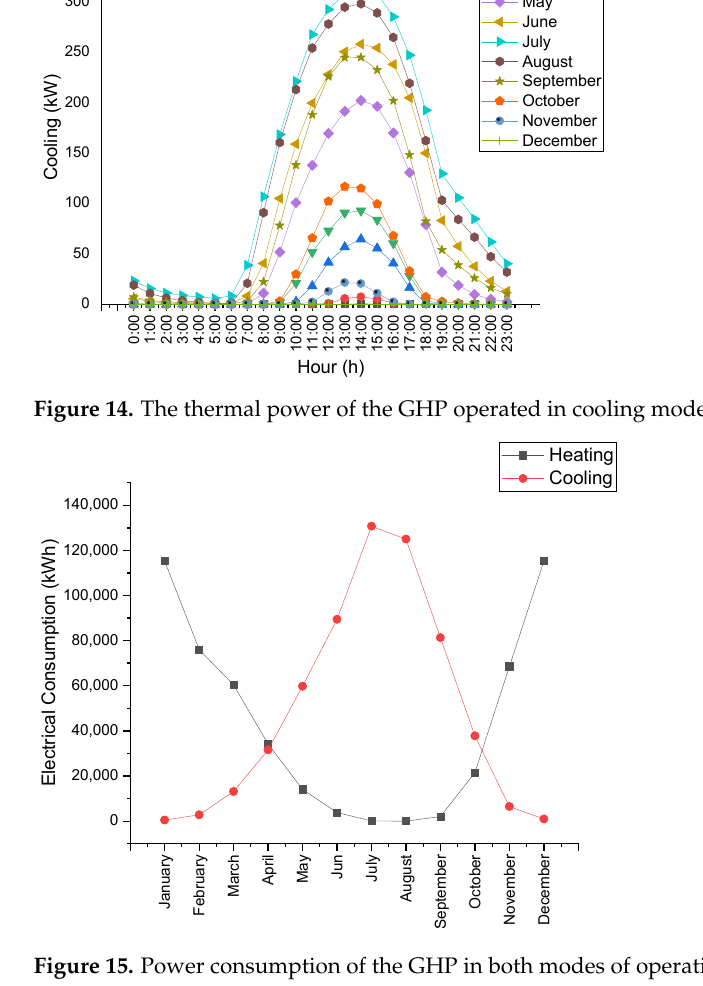
Processes 2022 , 10 , x FOR PEER REVIEW 15 of 17